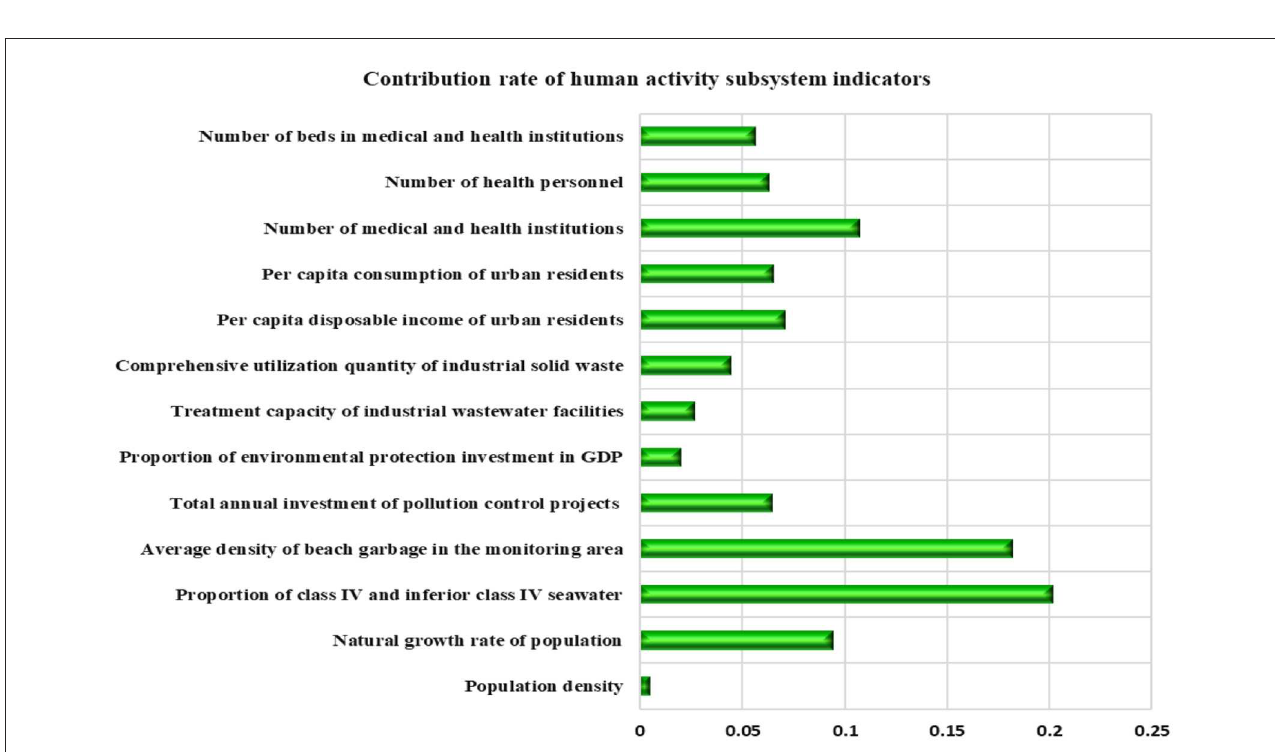
FIGURE9 Index contribution rate of coastal human activities subsystem in Shandong